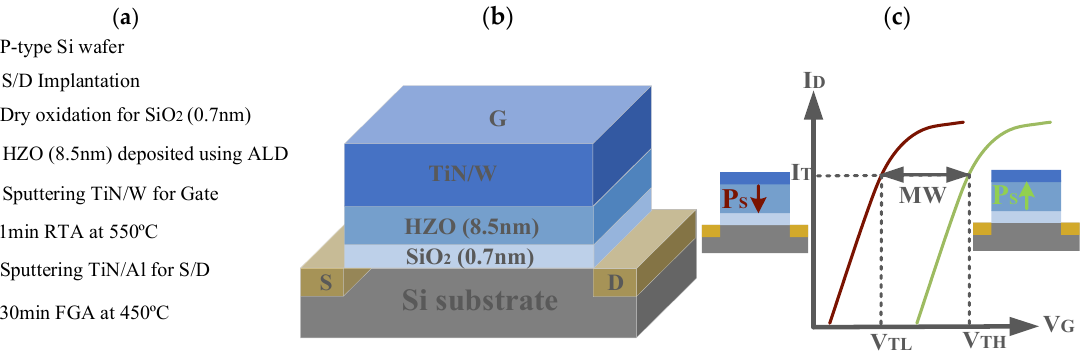
Figure 1. ( a ) Key fabrication process steps and ( b ) schematic structure for the fabricated Hf 0.5 Zr 0.5 O 2 (HZO) ferroelectric field effect transistor (FeFET) devices. ( c ) The transfer characteristic curves ( I D - V G ) under the opposite spontaneous polarization ( P S ) directions for the